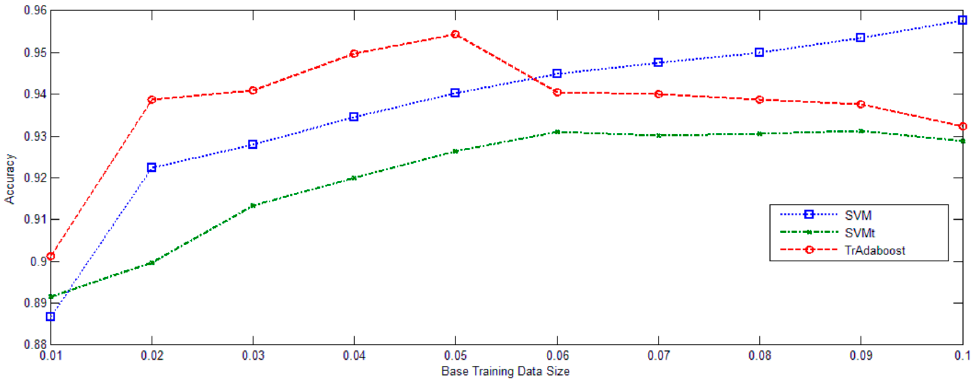
Figure 6. The accuracy curves on different ratios between training and testing.